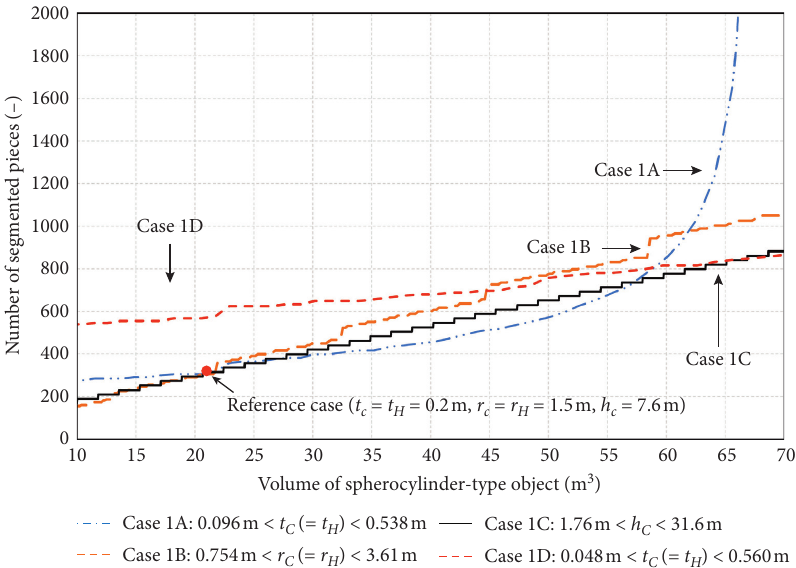
Figure 13: Number of segmented pieces along with variation of the volume of spherocylinder-type object from 10 m 3 by changing one parameter only for each case (i.e., thickness in Case 1A, height in Case 1B, and inner radius of object in Case 1C). Case 1D represents a priori circumferential segmentation in half of the same object assumed in Case 1A and application of generalized segmentation approach.